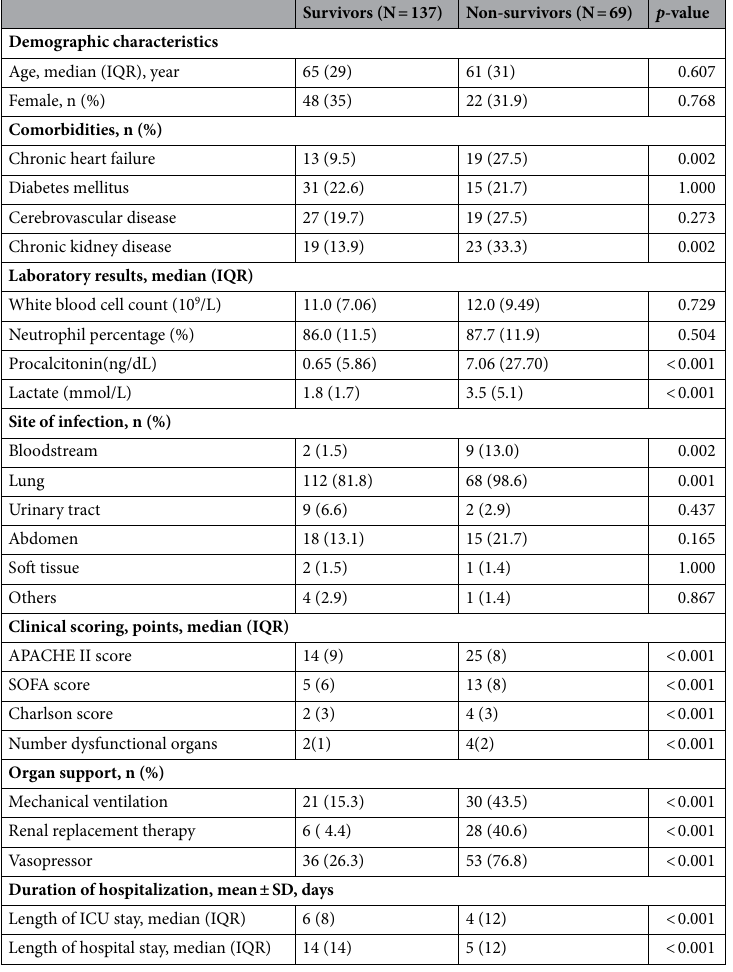
Table 1. Comparisons of baseline characteristics and outcomes between survivors and nonsurvivors in patients with severe sepsis and septic shock.